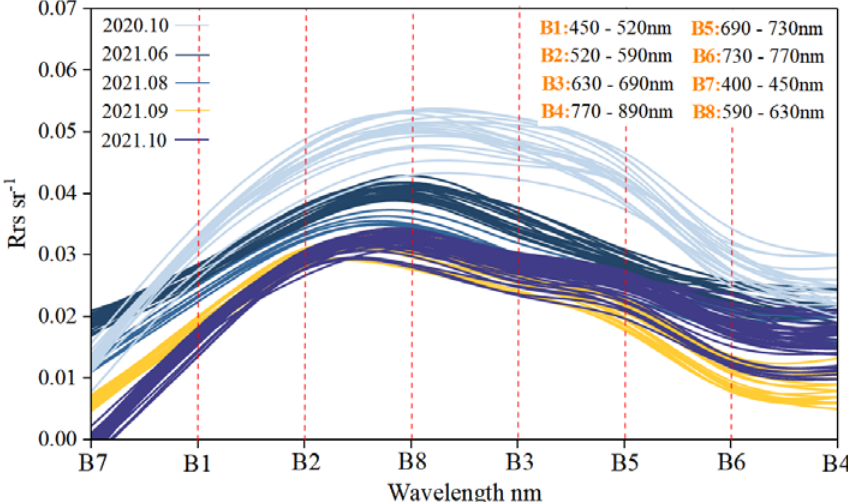
Figure 4. The remote sensing reflectance ( Rrs ) spectra of collected samples from GF WFV images after FLAASH atmospheric correction.